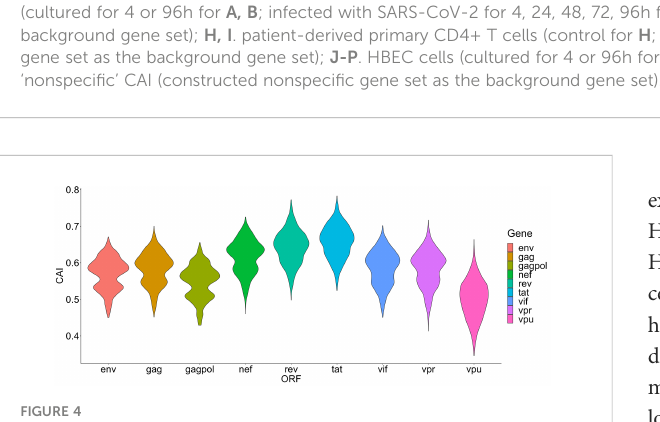
FIGURE 4 The overall CAI value distribution of different HIV-1 ORFs in all unstimulated cell types/subtypes/large groups from bulk RNA-seq datasets and scRNA-seq datasets shown by violin plot. Each violin shows the overall CAI value distribution of a speci fi c HIV-1 ORF in all cell types/subtypes/large groups (containing genomes of 58 HIV-1 strains belonging to 20